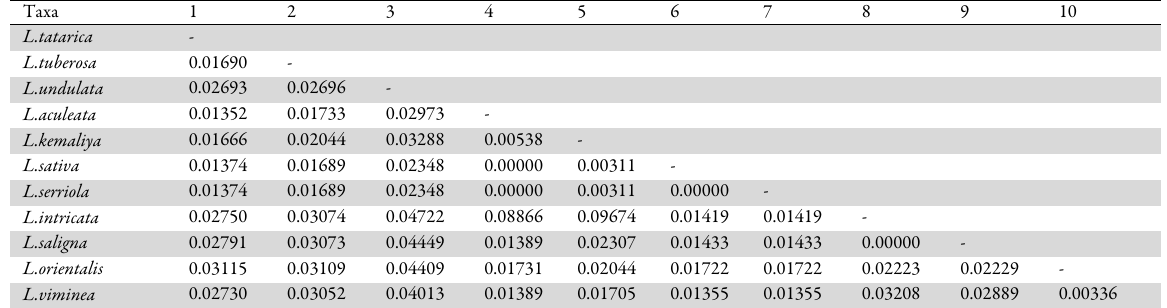
Table 3. Pairwise sequence distances among some Lactuca species for trn L-F cpDNA data using PAUP distance matrix (except outgroup) Taxa